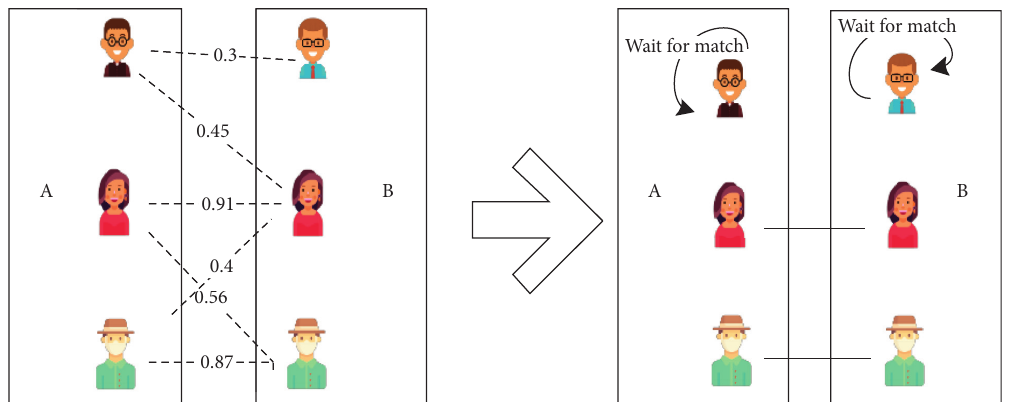
Figure 5: The process of user pair two-way matching.